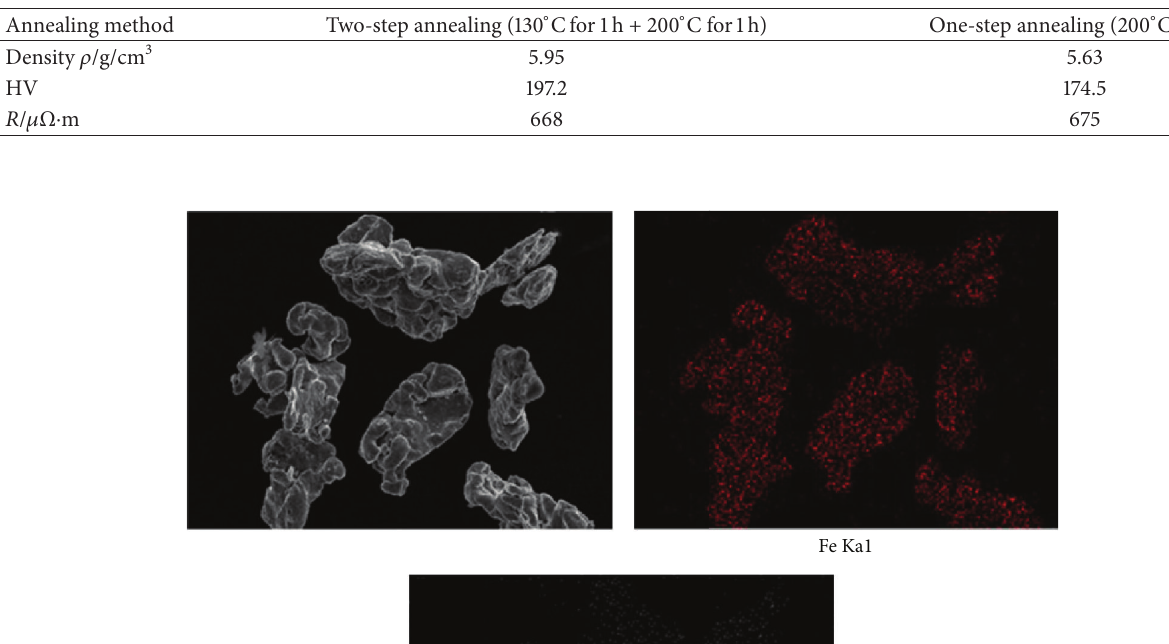
Table 1: Basic performance through different annealing methods.